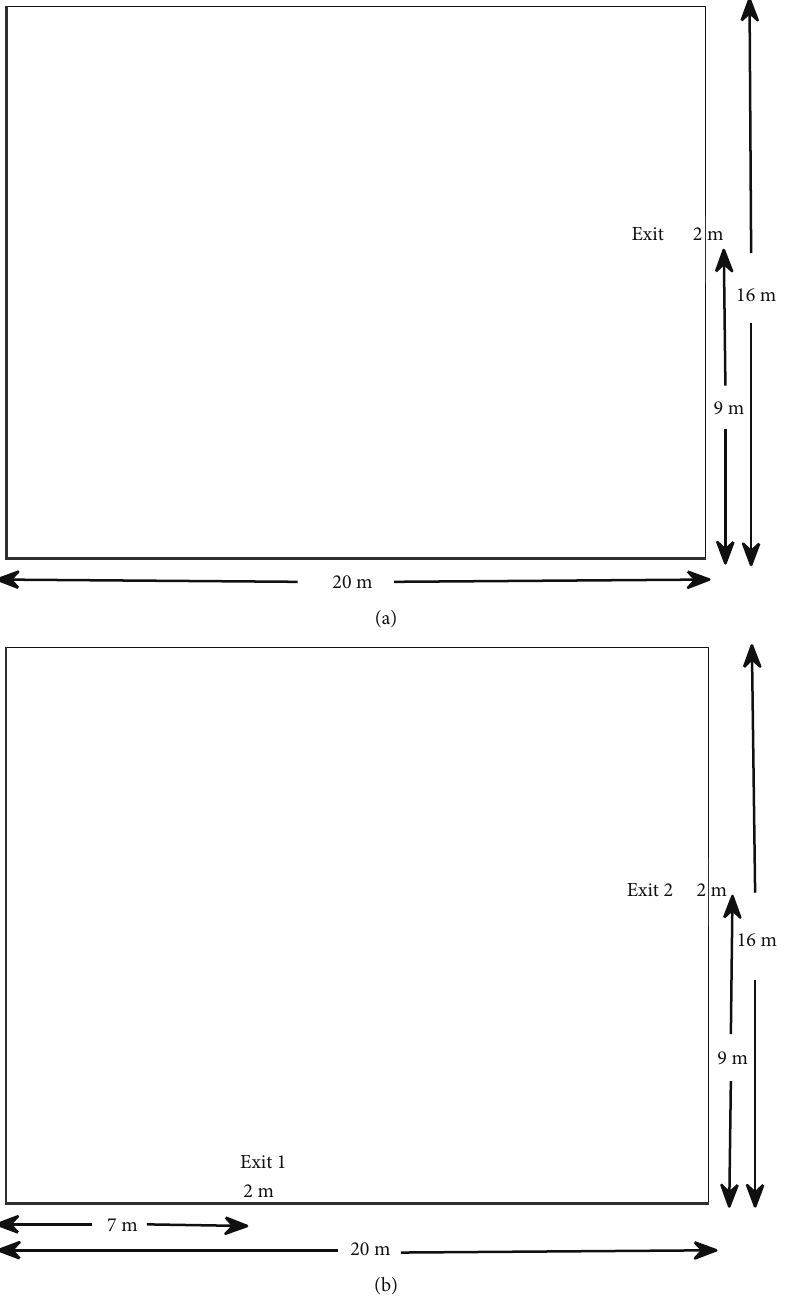
Figure 3: Modeling area for the numerical experiments in 2